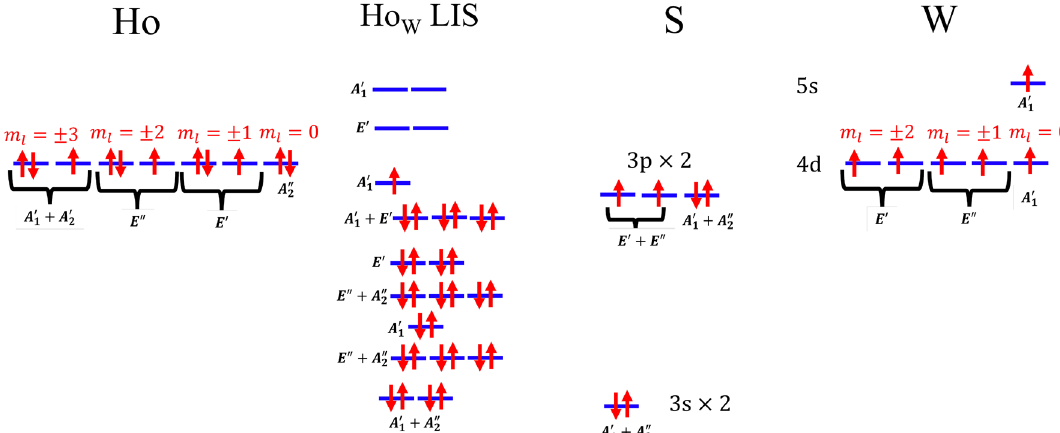
Figure 5. Molecular orbital diagram of Ho f orbitals in WS 2 , giving rise to the Ho W LIS shown in the bandstructure in Fig. 2. The states are labeled with the IRs of the point group D 3 h